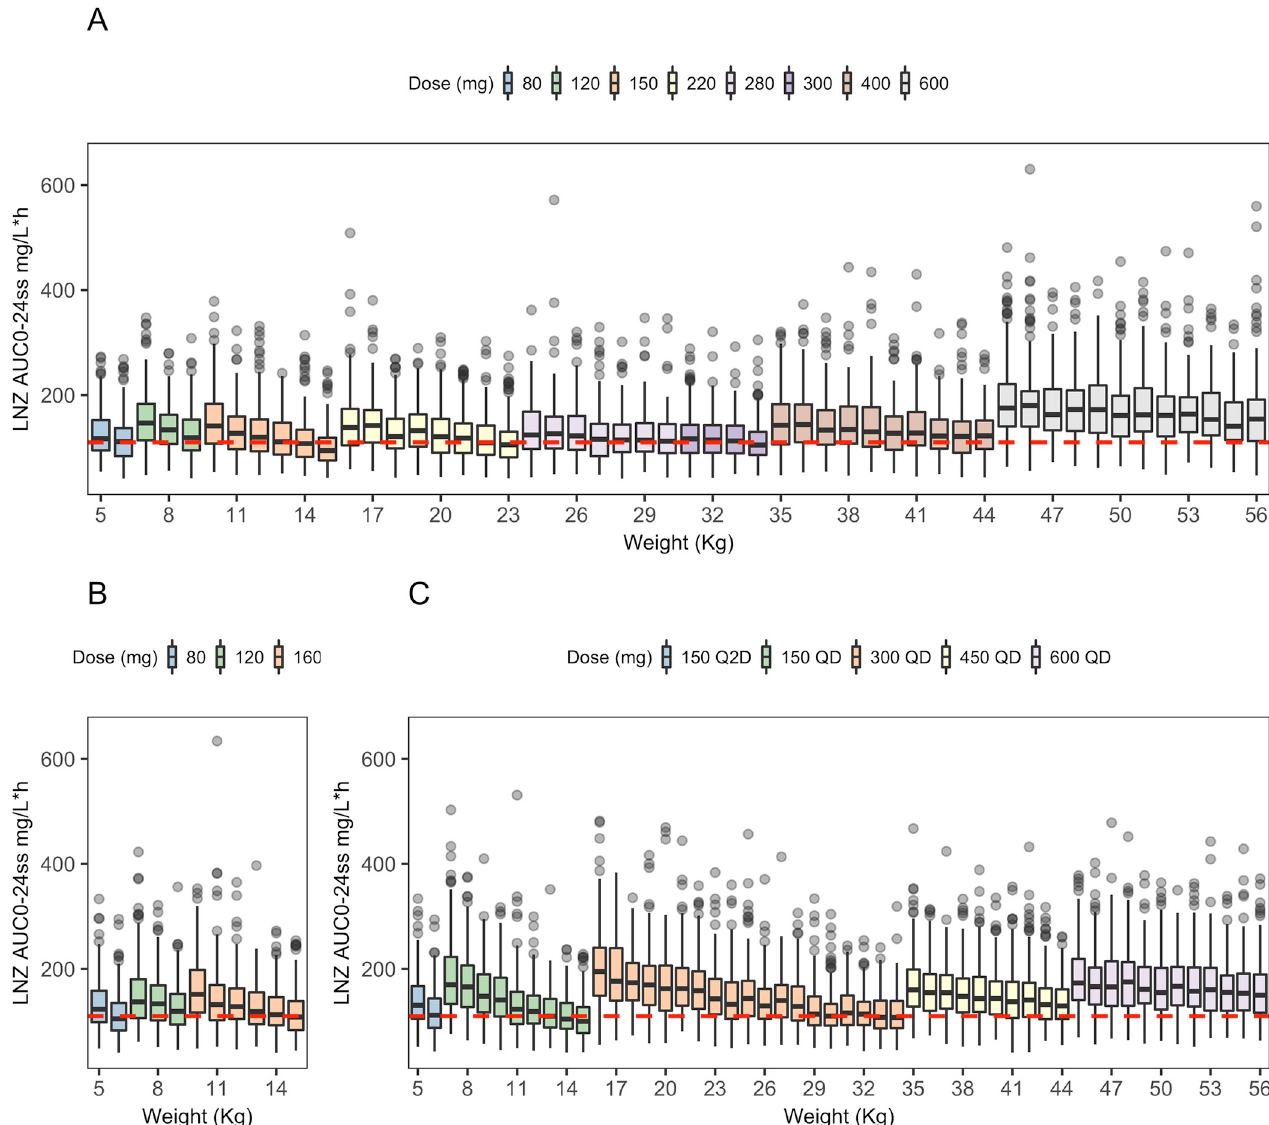
Fig 2. Simulated linezolid exposures in children with model-identified optimal doses. Simulated linezolid AUC 0–24ss versus body weight using the linezolid doses listed in Table 4 for (a) model-identified optimal doses independent of formulation, (b) optimal doses for the 20 mg/mL suspension, (c) optimal doses for the 600 mg tablet administered in one-fourth tablet increments; the red hashed line indicates the adult target exposure (AUC 0–24ss 110 mg/L . h). AUC 0–24ss , area under the concentration time curve from 0 to 24 hours at steady state; LNZ, linezolid; Q2D, once every other day; QD, once daily.